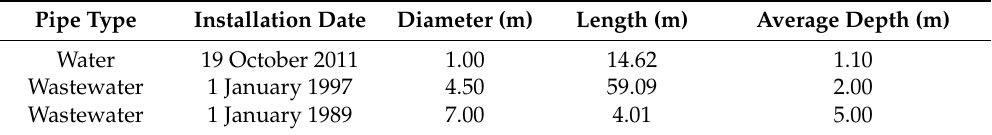
Table 1. Examples of data for computing the risk level.